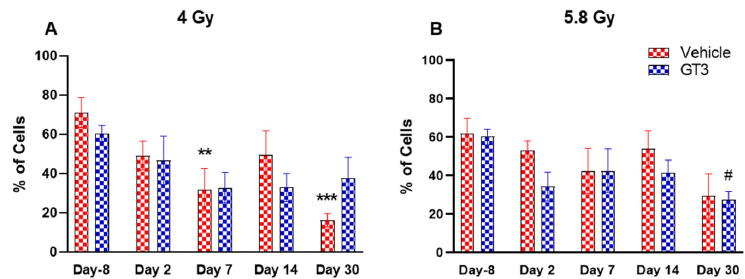
Figure 4. Effects of 4 Gy ( A ) and 5.8 Gy ( B ) on CD45 expression in BM of NHPs. NHPs received GT3 (37.5 mg/kg) or vehicle 24 h prior to irradiation (4 and 5.8 Gy). BM was collected at various time points and expression of CD45 + cells were analyzed. Data are expressed as mean ± SEM. ** p < 0.01, *** p < 0.001 vs. vehicle day-8; # p < 0.05 vs. GT3 day-8.